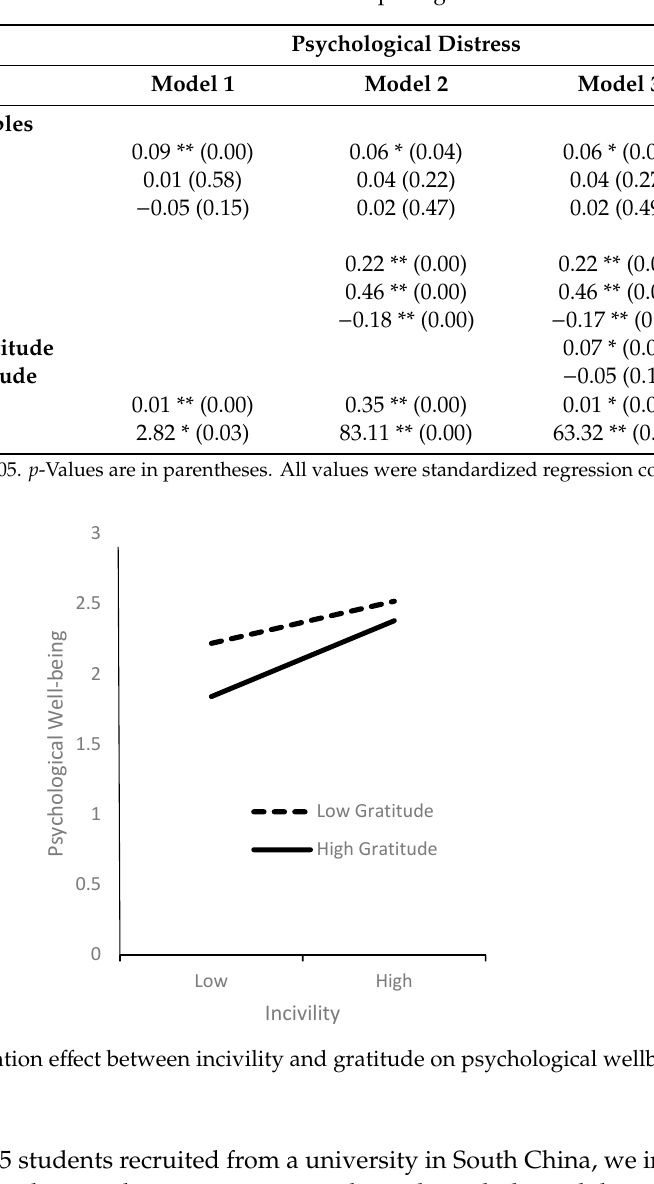
Table 3. Results of hierarchical multiple regression.